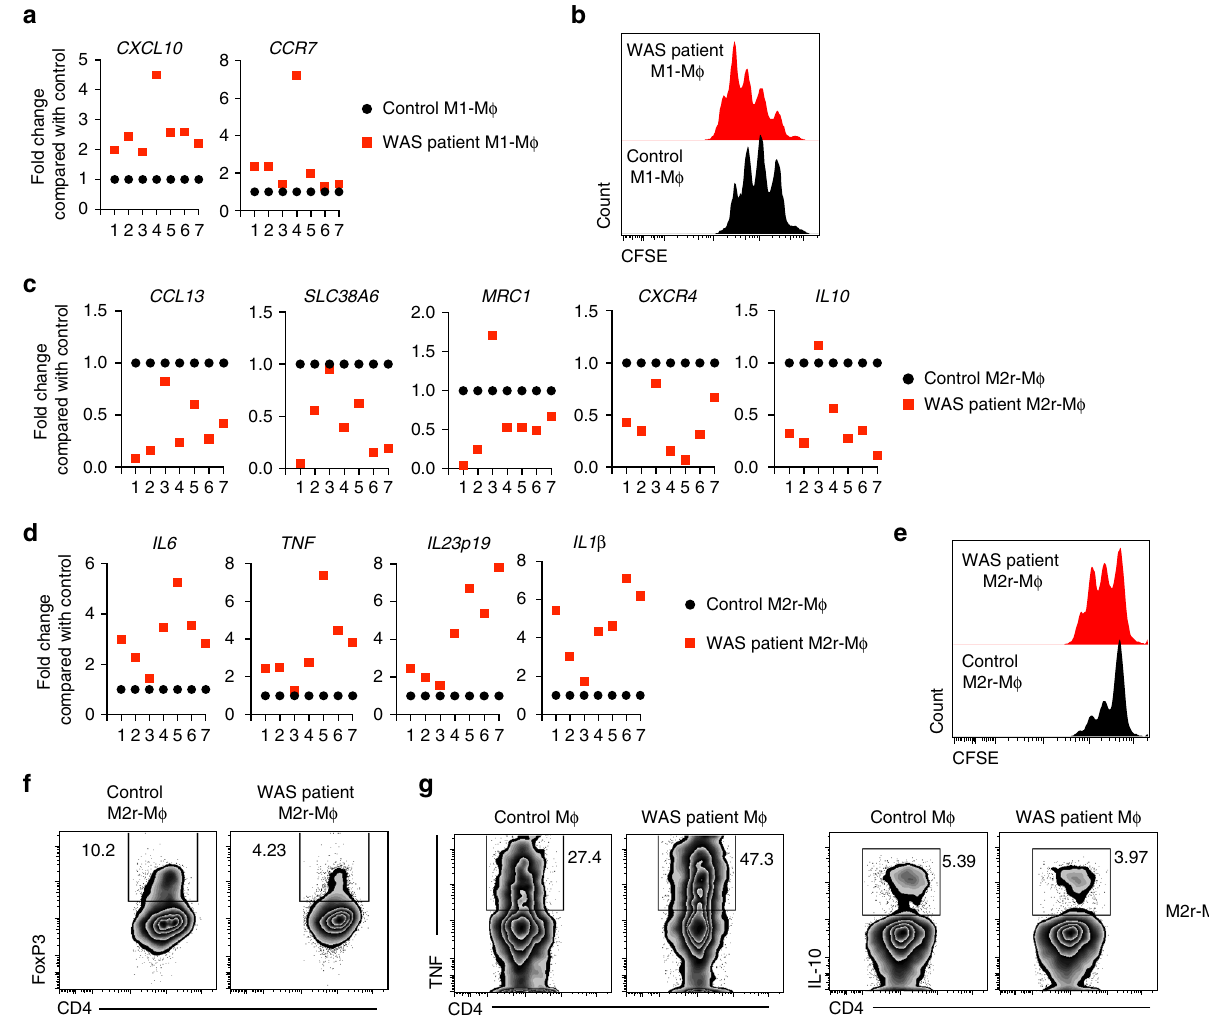
Fig. 7 Macrophage differentiation and function is impaired in patients with WAS. Monocyte-derived macrophages form healthy donors (control) and patients with WAS were differentiated into M1 macrophages. a Expression of M1-speci fi c markers was analysed by qPCR. b Naive CD4 + CD25 − T cells were CFSE labelled and cultured in the presence of plate-bound anti-CD3 (2 μ g/ml) and either control or WAS patient-derived M1 macrophages for 3 days. T-cell proliferation was determined by fl ow cytometer. Data are representative of two independent experiments with two patient samples. Monocyte derived macrophages form healthy donors (control) and patients with WAS were differentiated into M2r macrophages. c Expression of M2-speci fi c markers was analysed by qPCR. d M2r differentiated monocyte-derived macrophages were restimulated with LPS for 4 h. Expression of pro-in fl ammatory genes were analysed by qPCR. e Naive CD4 + CD25 − T cells were CFSE labelled and cultured in the presence of plate-bound anti-CD3 (2 μ g/ml) and either control or WAS patient-derived M2r macrophages for 4 days. T-cell proliferation was determined by fl ow cytometer. Data are representative of two independent experiments with two patient samples. f Naive CD4 + CD25 − T cells were cultured in presence of plate-bound anti-CD3 (2 μ g/ml), TGF- β (2 ng/ml) and either control or WAS patient-derived M2r macrophages for 5 days. Treg generation was examined by analysing FOXP3 expression using fl